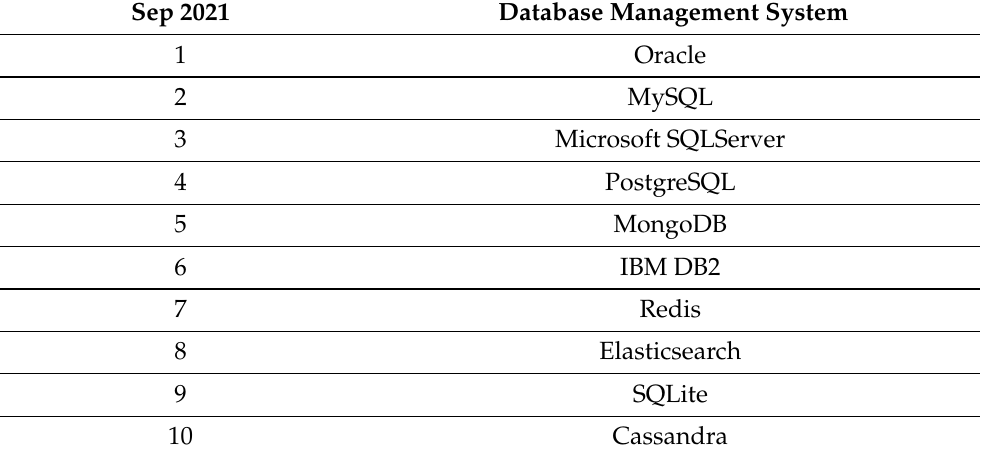
Table 1. Most popular